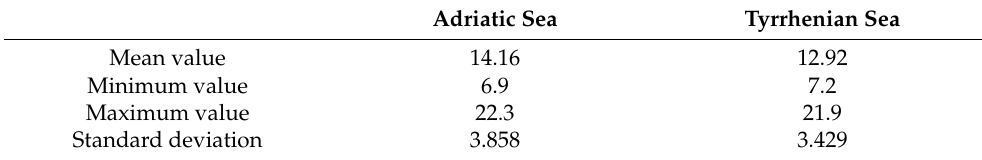
Table 1. Adhered materials on the mussel socks (% of dry weight). N = 20 + 20.